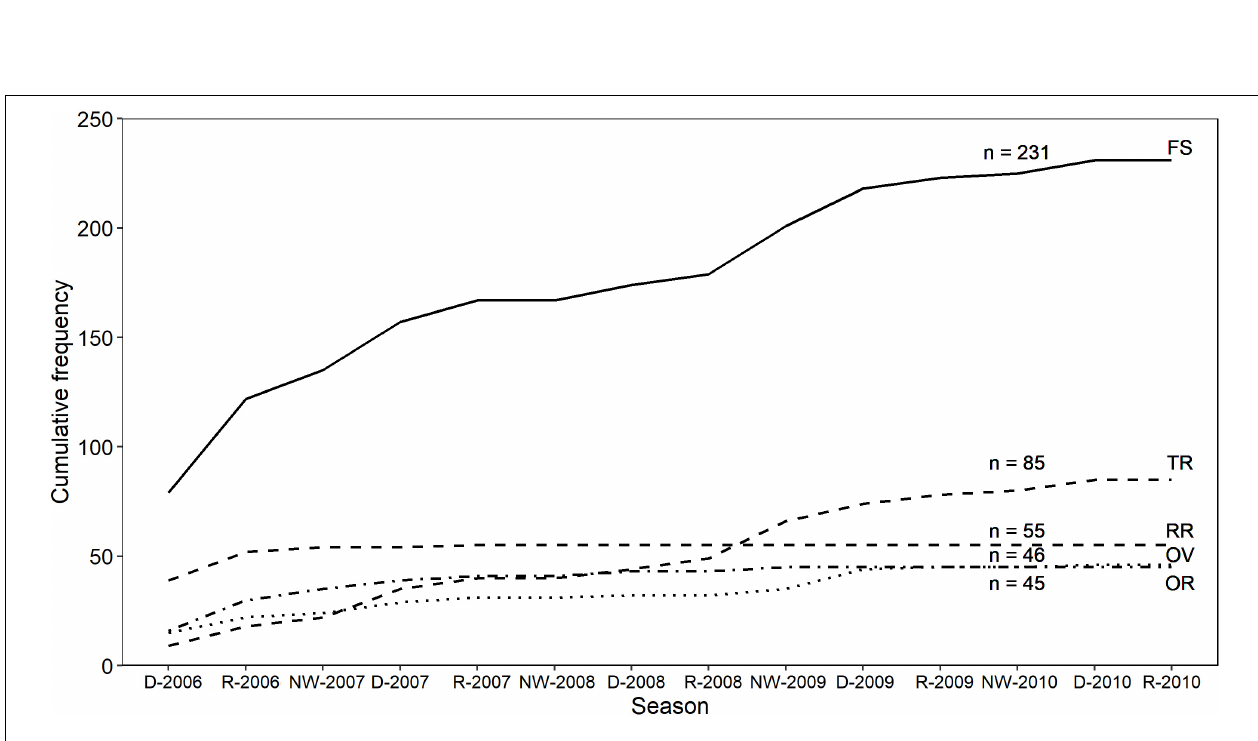
FIGURE 4 | Discovery curve of the cumulative frequency of newly identified bottlenose dolphins off the Alvarado Lagoon System, between 2006 and 2010, by residency pattern. FS = full sample, TR = transients, RR = regular residents, OV = occasional visitors, OR = occasional residents, NW = Northern Winds. Number of individuals belonging to each cluster are